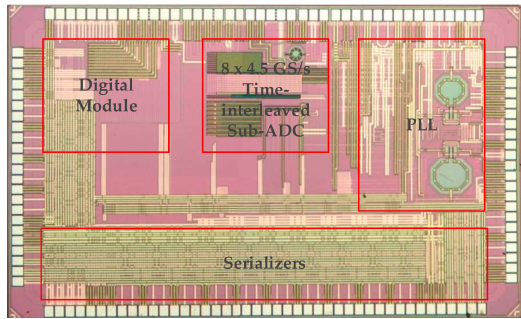
Figure 14. The micrograph of prototype ADC.